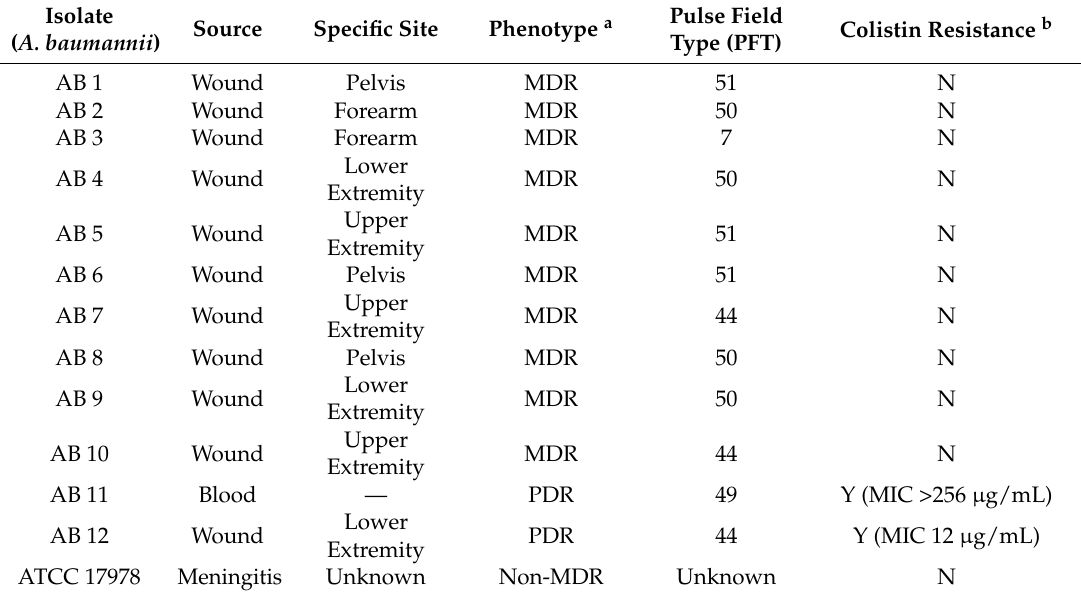
Table 1. Characteristics of strains used in this